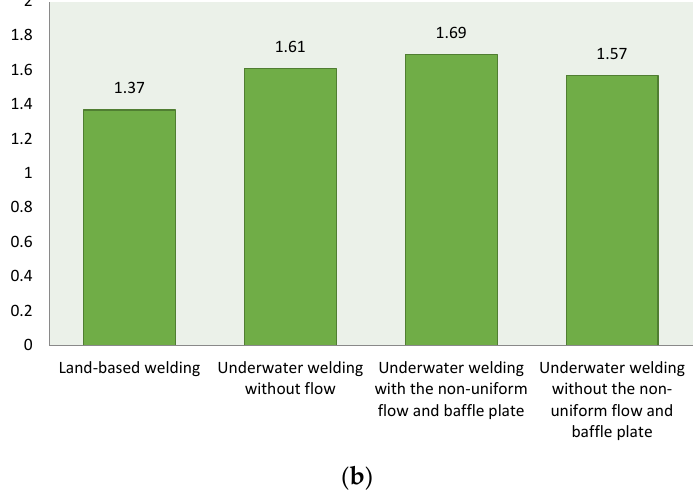
Figure 22. Graph of impact test results on welding specimens. ( a ) Adsorbed energy (Joule). ( b ) Impact strength (J/mm 2 ).